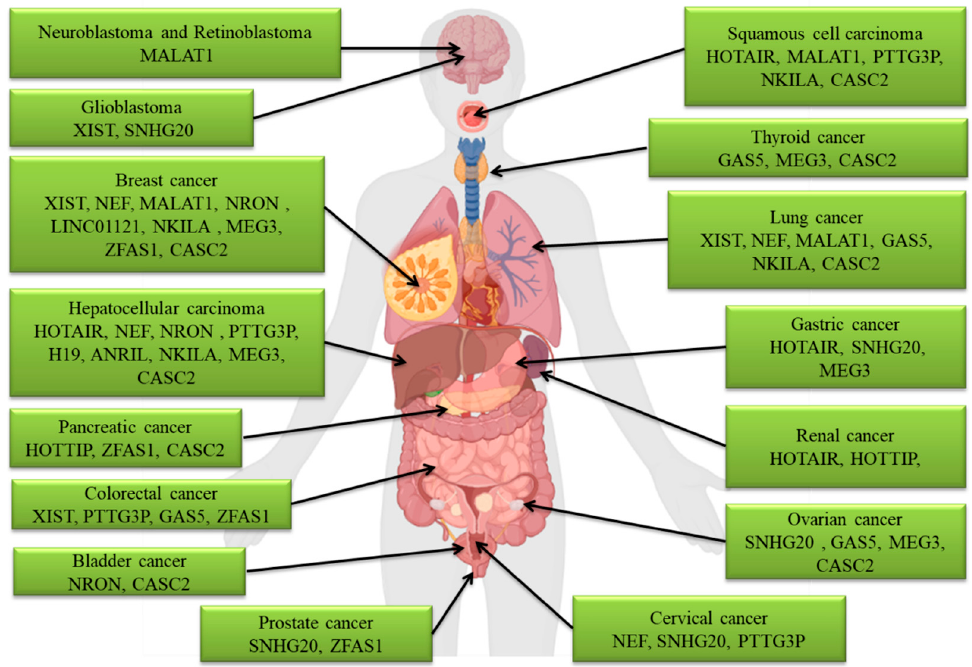
Figure 2. LncRNAs with a role in the invasion, migration, and metastasis of different types of can-